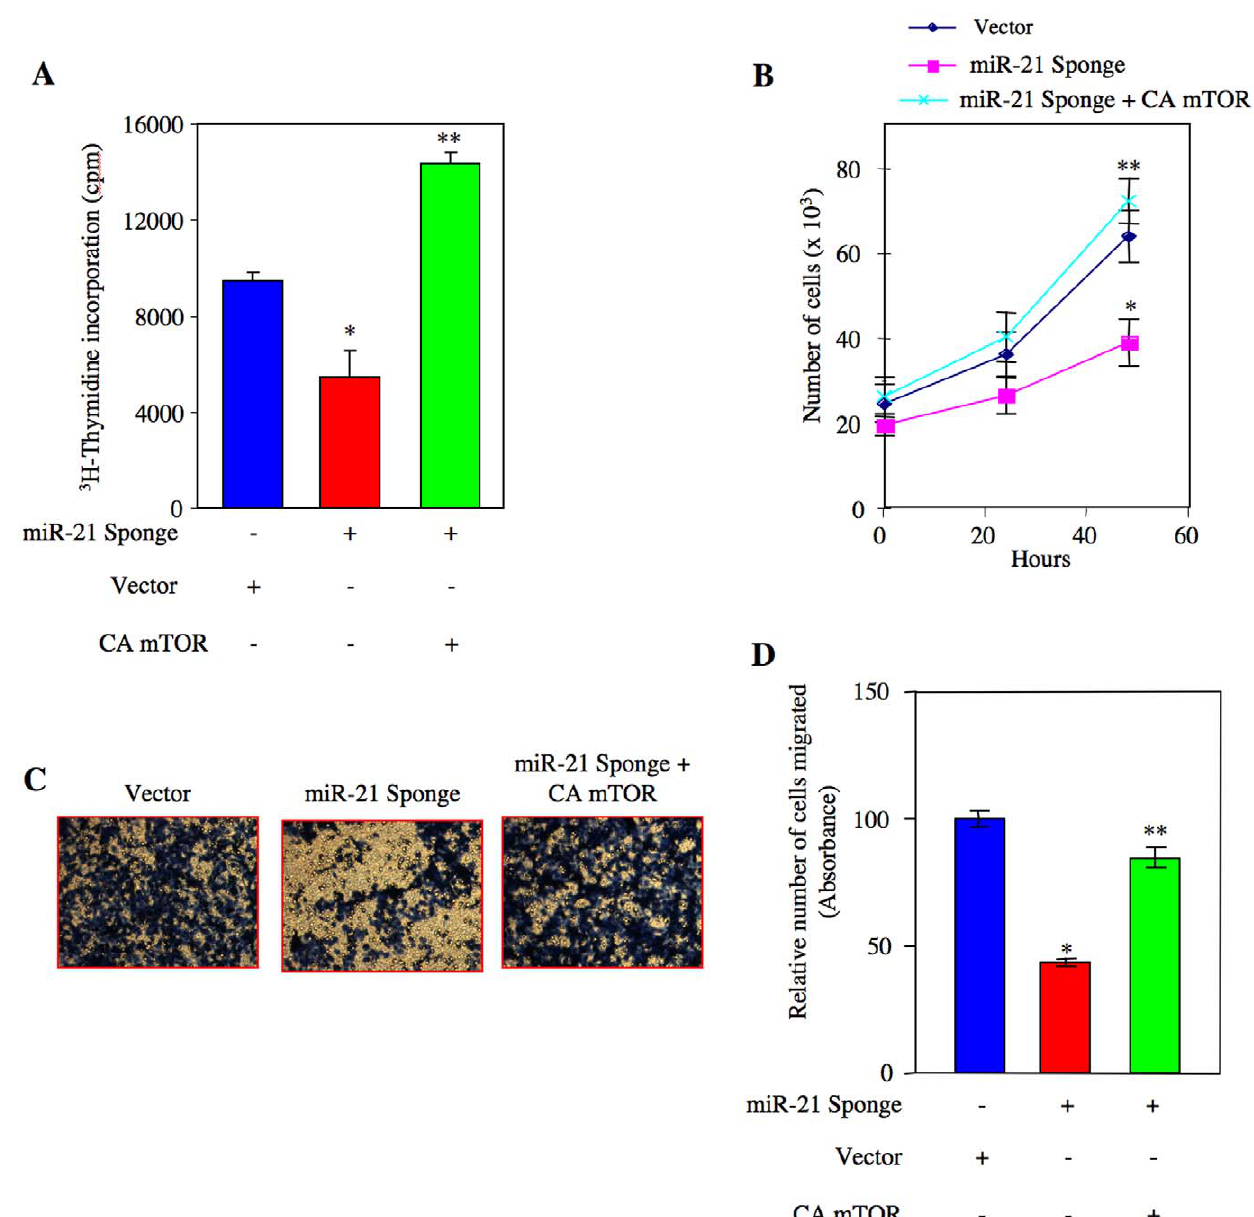
Figure 8. miR-21 regulates proliferation and migration of renal cancer cells through activation of TORC1. ACHN cells were transfected with miR-21 Sponge along with constitutively active mTOR plasmids as indicated. (A) 3 H-thymidine incorporation was determined as described in the Materials and Methods [115]. Mean 6 SE of 6 measurements is shown. *p , 0.001 vs vector; **p , 0.001 vs miR-21 Sponge alone. (B) Transfected cells were counted at indicated time periods. The symbols diamond, square and cross represent vector, miR-21 Sponge and miR-21 Sponge plus constitutively active (CA) mTOR expression plasmids, respectively. *p , 0.01 vs vector alone; **p , 0.001 vs miR-21 Sponge alone. (C) Transfected cells were seeded onto membrane in trans-well chambers and the migrated cells were stained as described in the Materials and Methods [111]. (D) Stains from the membranes in panel C were eluted and absorbance at 590 nm was measured. Mean 6 SE of 3 independent chambers is shown. *p , 0.001 vs vector alone; **p , 0.001 vs miR-21